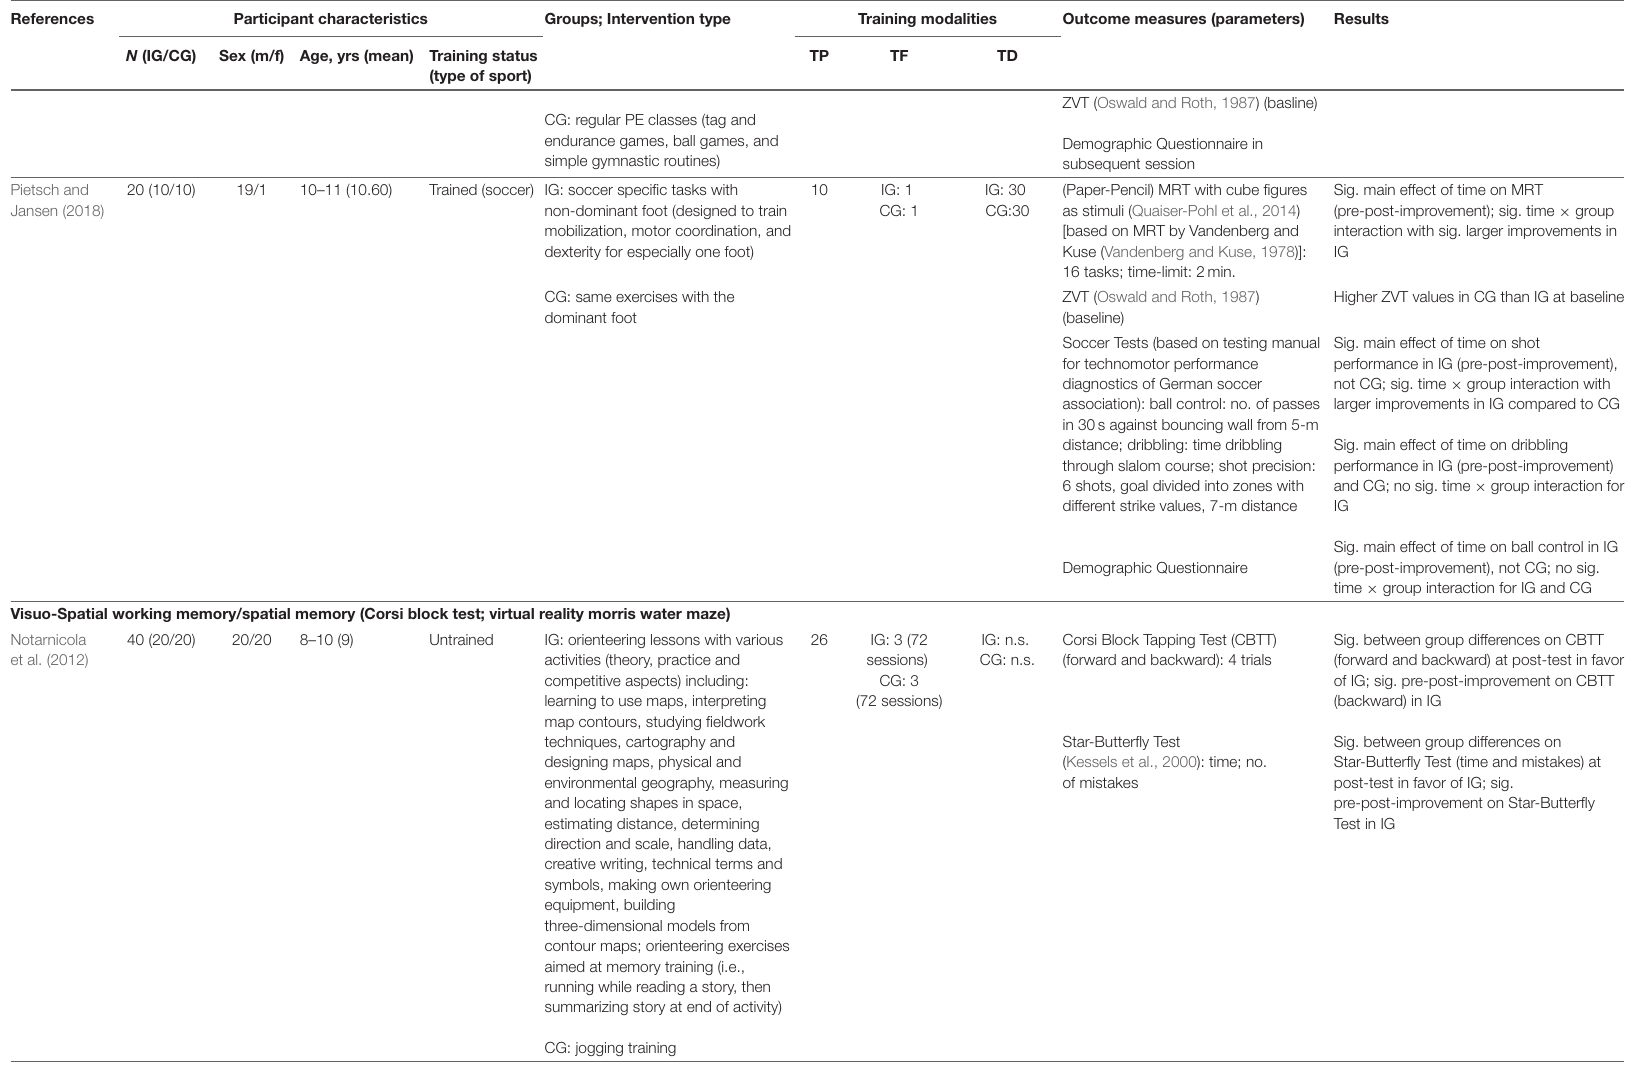
Groups; Intervention type Training modalities Outcome measures (parameters) Results